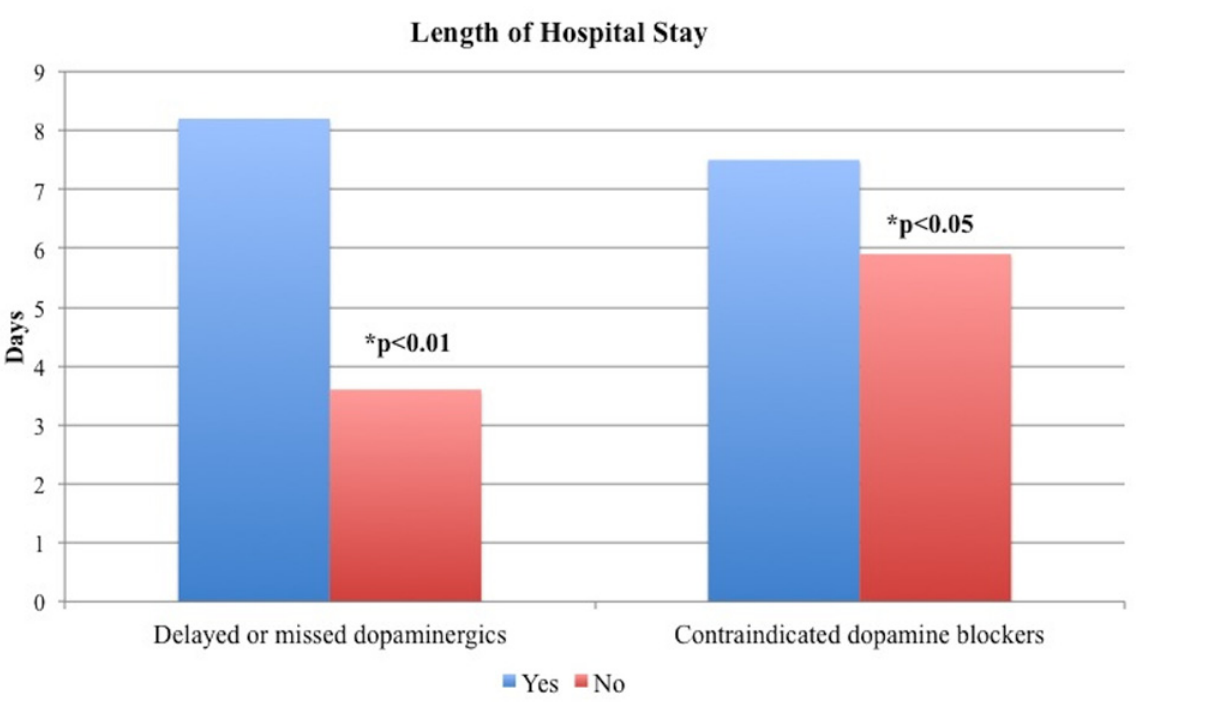
Fig 3. Effect of wrong administration of dopaminergic medications and neuroleptics on length of hospital stay (days).